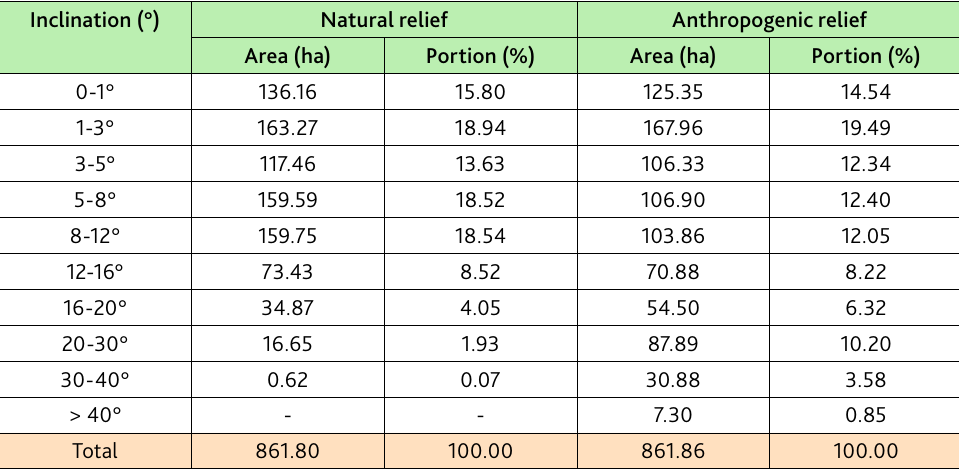
Table 2. Categories and spatial dimensions of slopes Inclination (°) Natural relief Anthropogenic relief